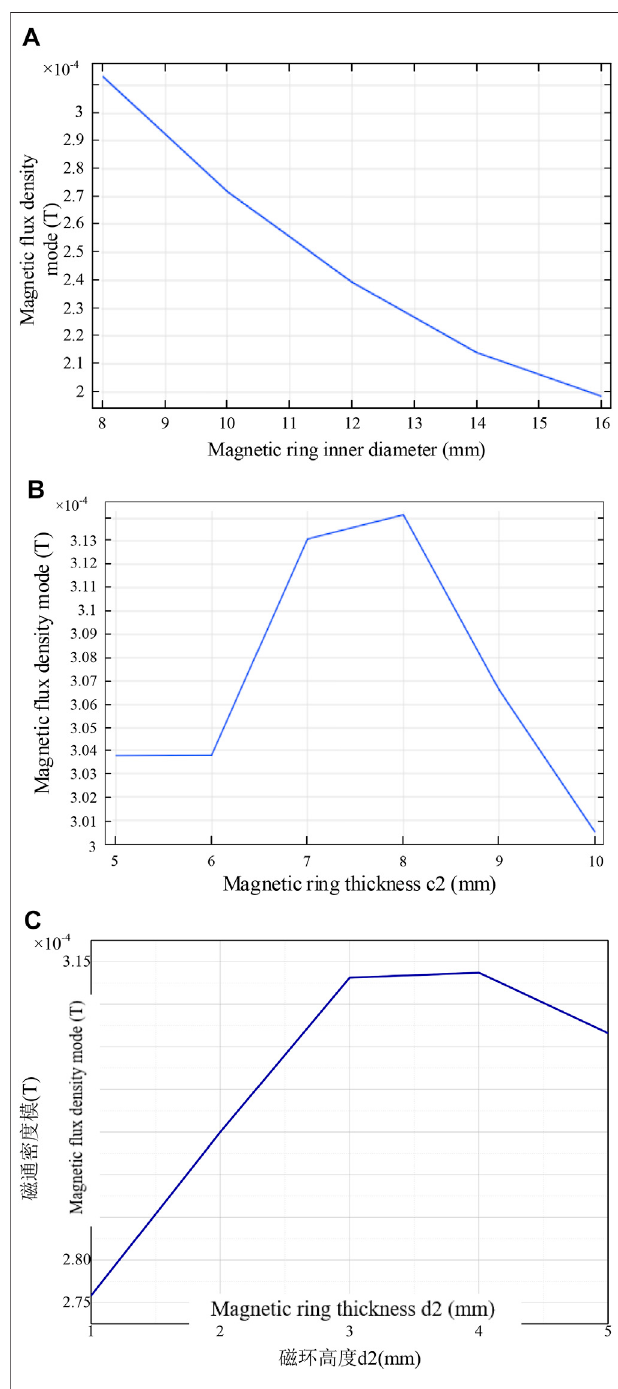
FIGURE 3 | Parametric scanning simulation results of the inner diameter of (A) magnetic core, (B) core thickness and (C) magnetic ring height parameterized